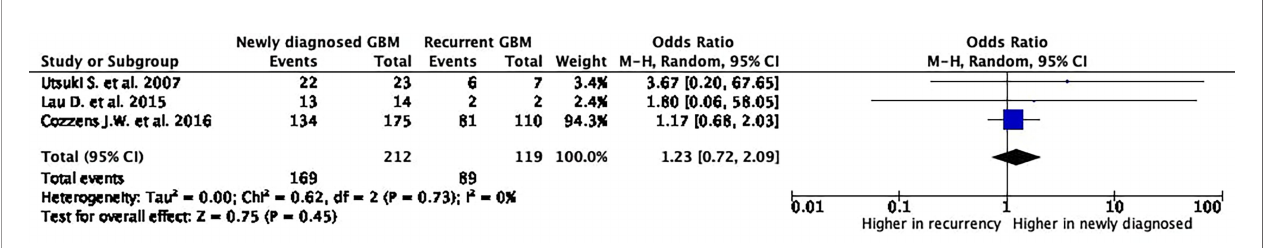
FIGURE 2 | 5-Aminolevulinic acid (5-ALA) fl uorescence rate in newly diagnosed and recurrent glioblastoma. The Foster Plot, from the meta-analyses of proportions to estimate the pooled rates of 5-ALA-positive fl uorescence rate in newly diagnosed and recurrent glioblastoma. According to the Plot, there are no signi fi cative differences comparing the pooled rates from the two meta-analytic groups (p